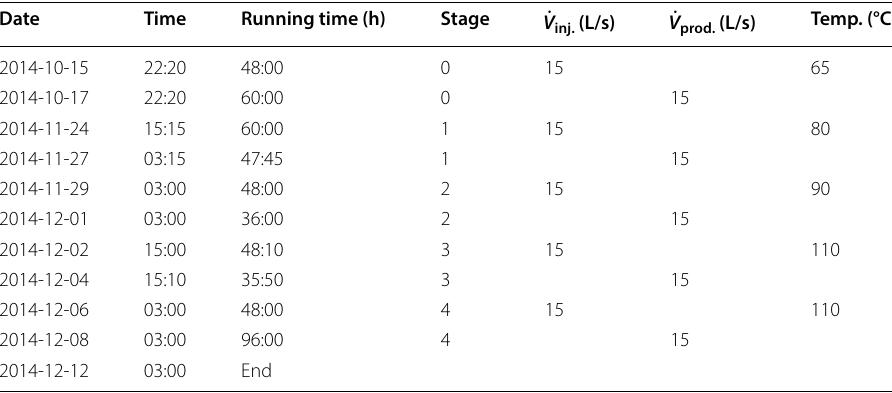
Table 1 Breakdown of the heat storage